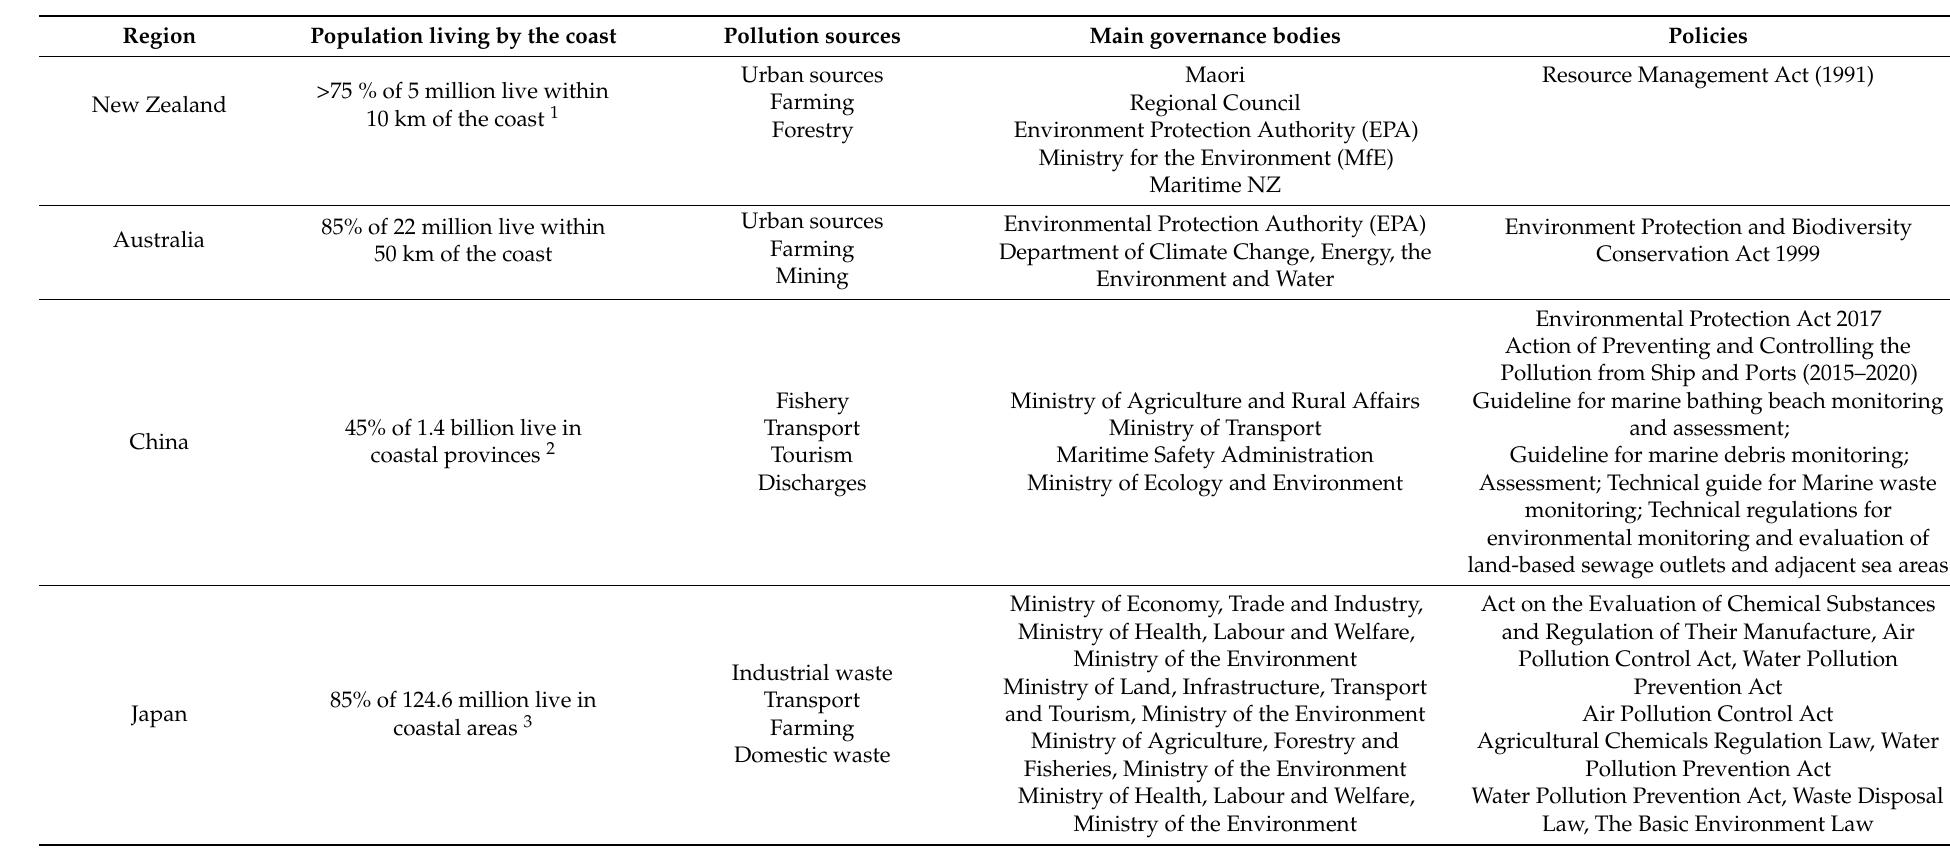
Table 1. Comparisons between the 4 countries within the Pacific region. The shared key stressors facing coastal zones in these regions include sediment, nutrient enrichment, chemical and waste pollution, plastic, pathogens, invasive species that are all compounded by climate